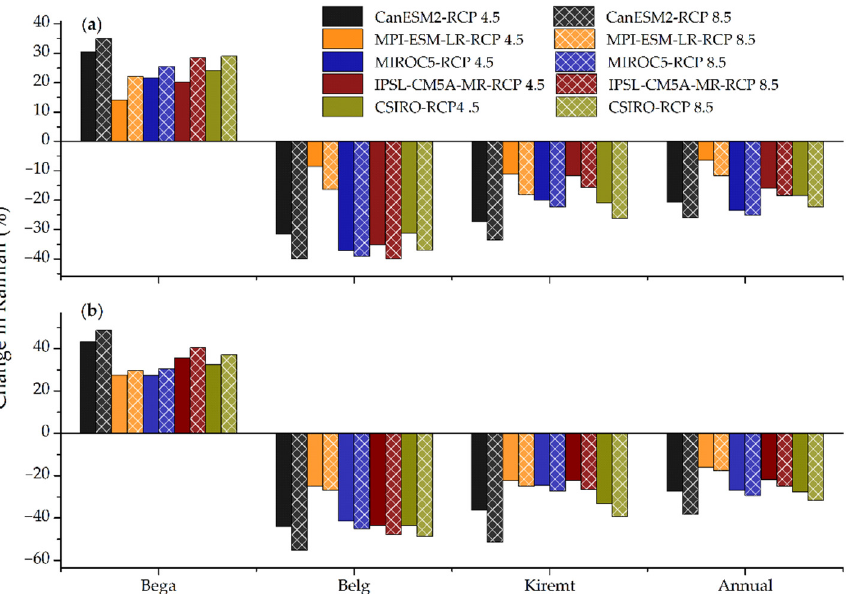
Figure 14. Percentage changes in annual and seasonal rainfall with reference to the baseline for ( a ) the near future period from 2021–2050; and ( b ) the far future period from